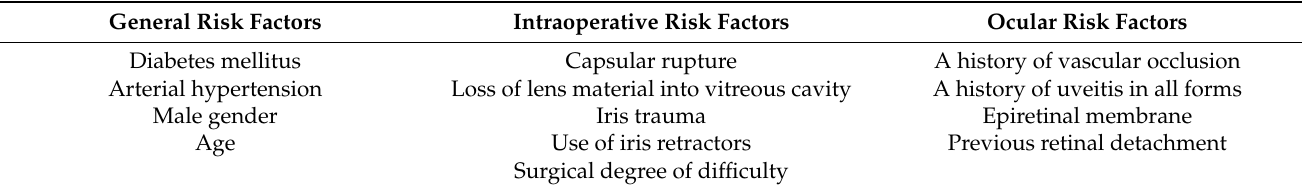
Table 5. Known risk factors for the development of PCME